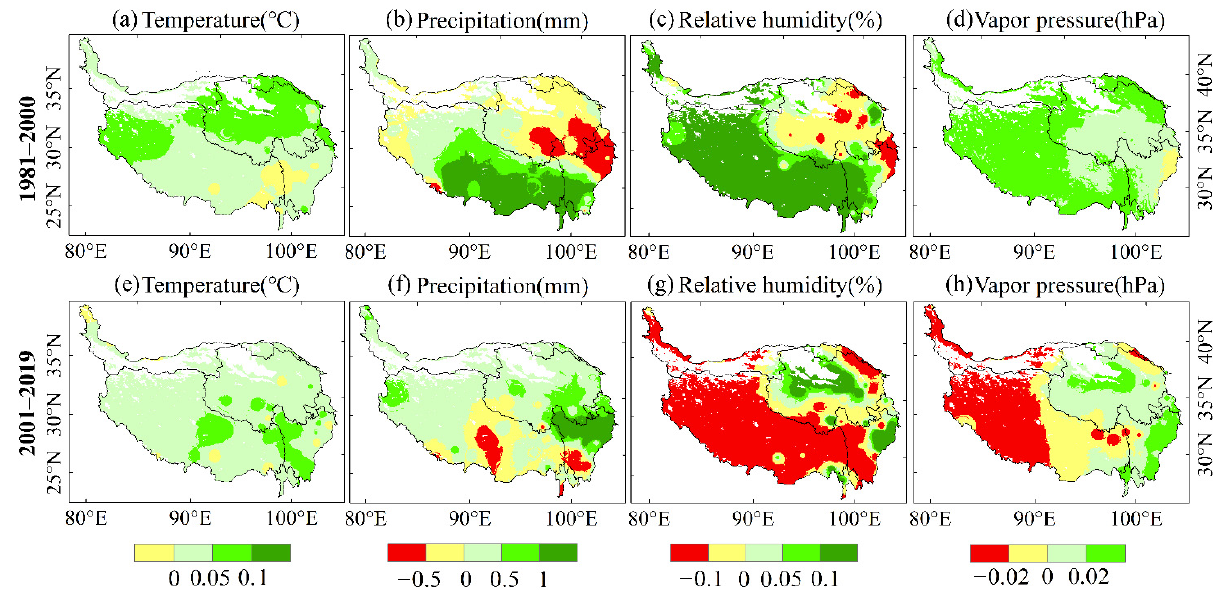
Figure 4. Trends of climatic variables from 1981 to 2000 ( a – d ) and from 2001 to 2019 ( e – h ) in the QTP using the modified MK test.